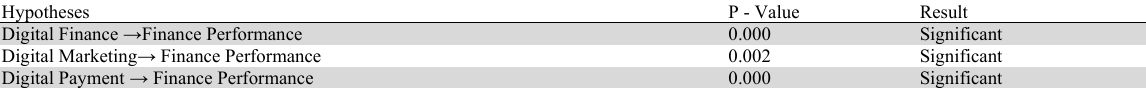
Hypotheses Testing for Direct